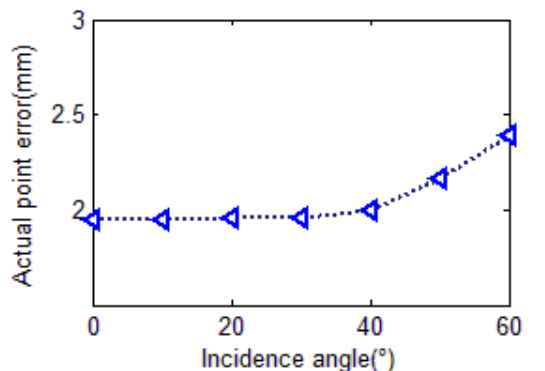
Figure 3. The actual point error of the laser point with the changing incidence angle.